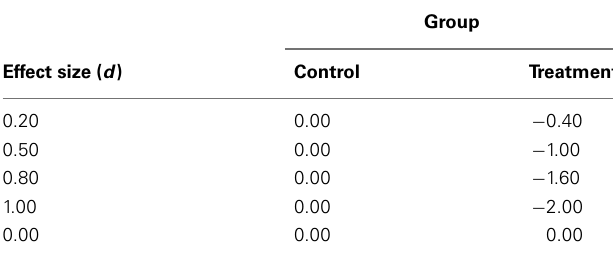
Table 4 | Summary of group-level fixed slopes for putative “control” and “treatment” groups at each simulated effect